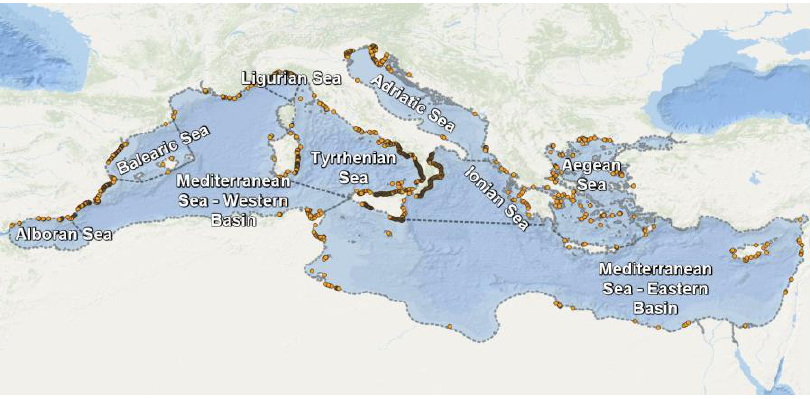
Figure 5. Spatial distribution of Cymodoceaceae in the Mediterranean Sea (UNEP-WCMC database).